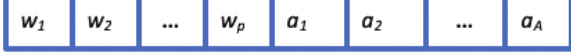
Figure 2: The search agent vector assigning of WOA on the